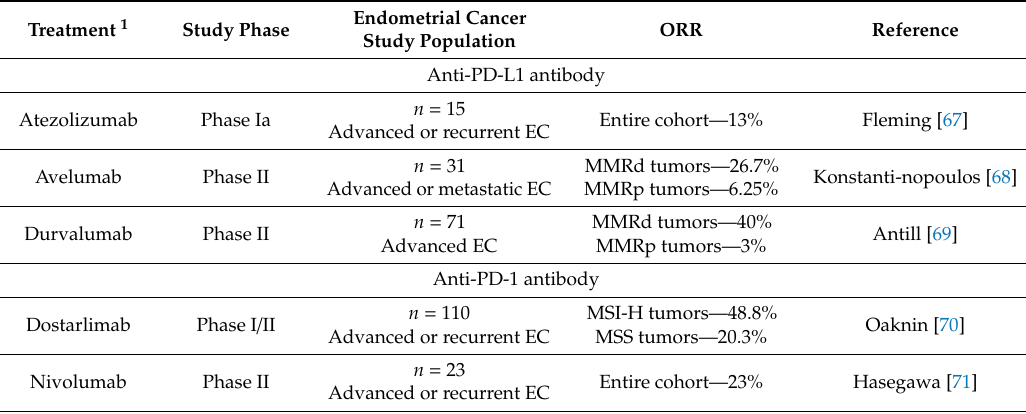
Clinical data for select immune checkpoint inhibitors evaluated as monotherapy in endometrial